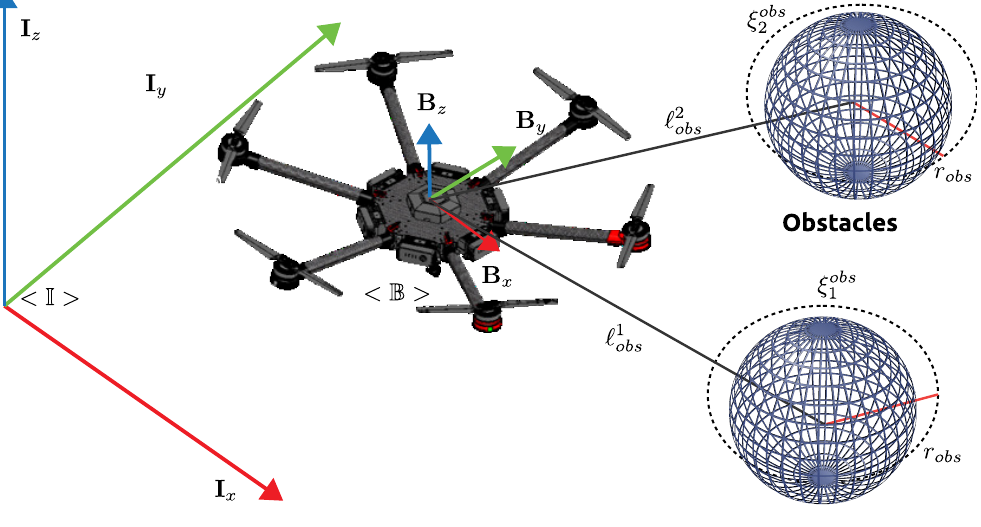
Figure 8. Representation of the hexacopter and